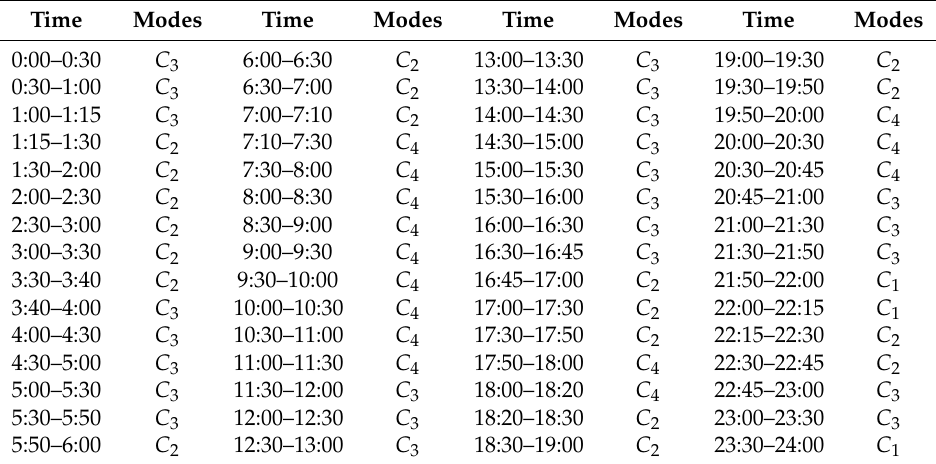
Table 1. Operation modes of CHP in real time.